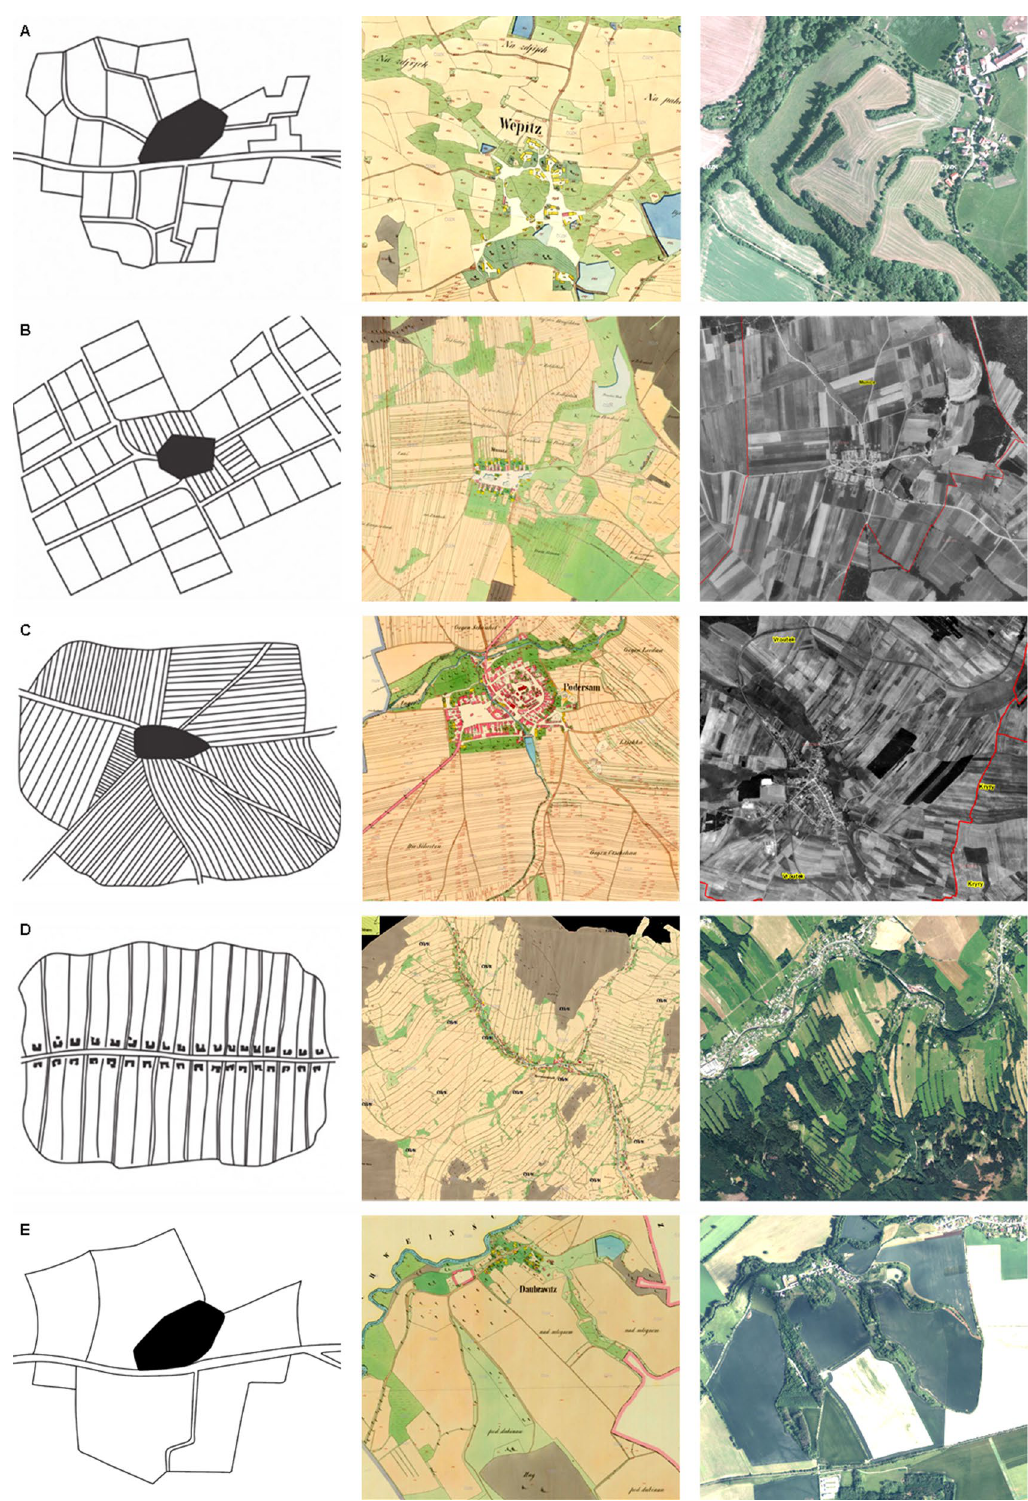
Figure 1. Five types of historical field pattern. ( A ) Segmental plužina (irregular, blocky structure; Czech: úseková ), ( B ) plužina of consolidated/unconsolidated segments (regular, narrow, short strips arranged in many rectangular quadrangles; Czech: scelené/dělené úseky ), ( C ) sectional plužina (narrow and medium-length strips parallel to each other, arranged into large irregular blocks; Czech: traťová ), ( D ) croft plužina (very long parallel strips following each homestead; Czech: záhumenicová/délková ), ( E ) without internal division, and others. First column: schematic drawing of the field pattern [drawings ( A – D ) by Šitnerová et al. 15 , after Černý 81 , drawing E by Václav Fanta, on the base of Černý’s 81 ], second column: Imperial Imprints of the Stable Cadastre mid- nineteenth century maps 82 , third column: historic ( B , C ) or recent ( A , D , E ) aerial photographs 82